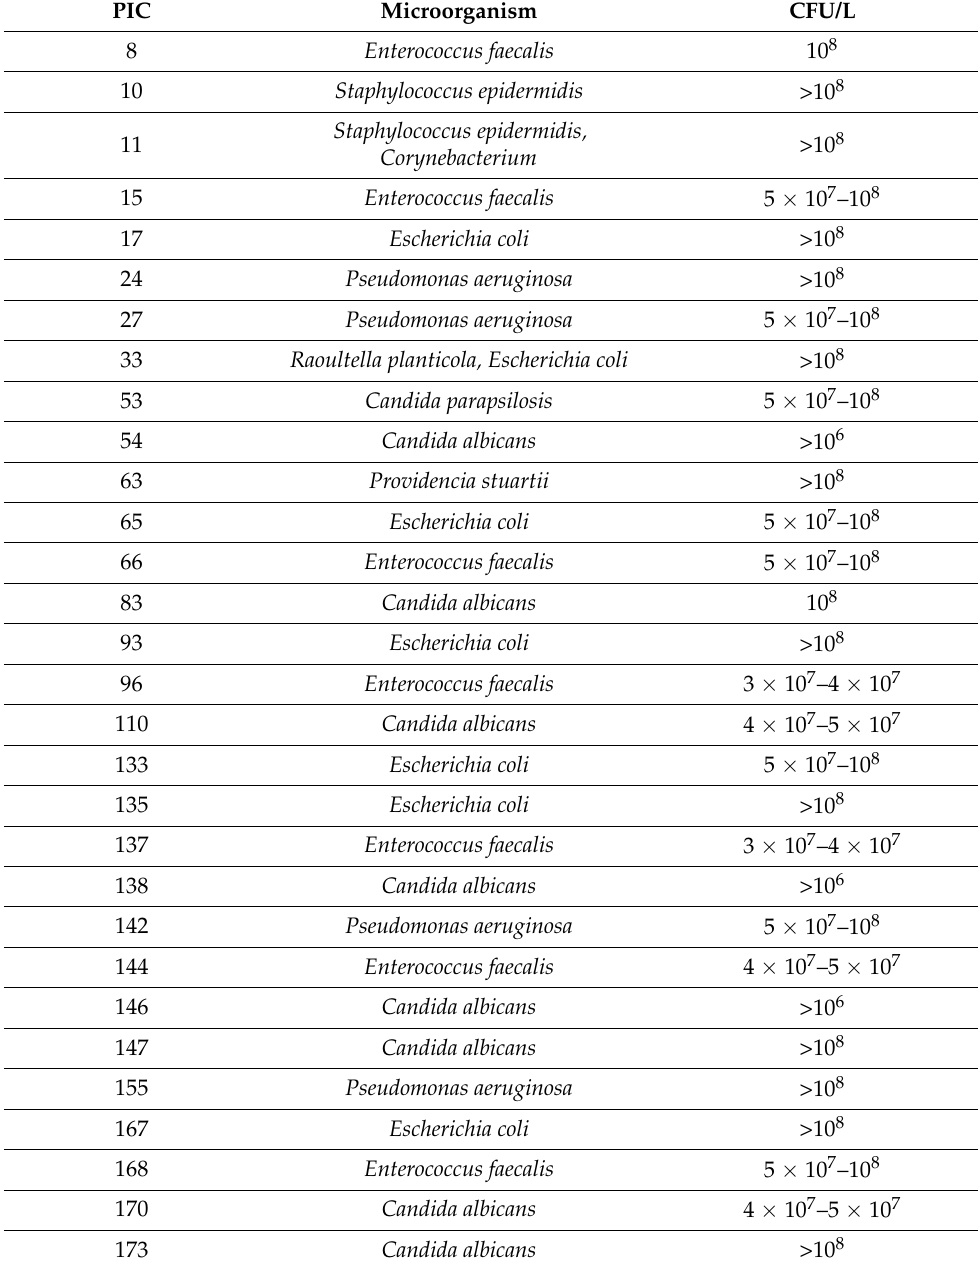
Table 3. Microorganisms isolated in UC patients with catheter-related